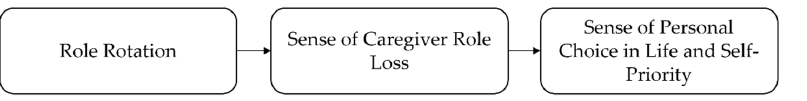
Figure 6. Role rotation, sense of caregiver role loss, and sense of personal choice in life and self- priority.